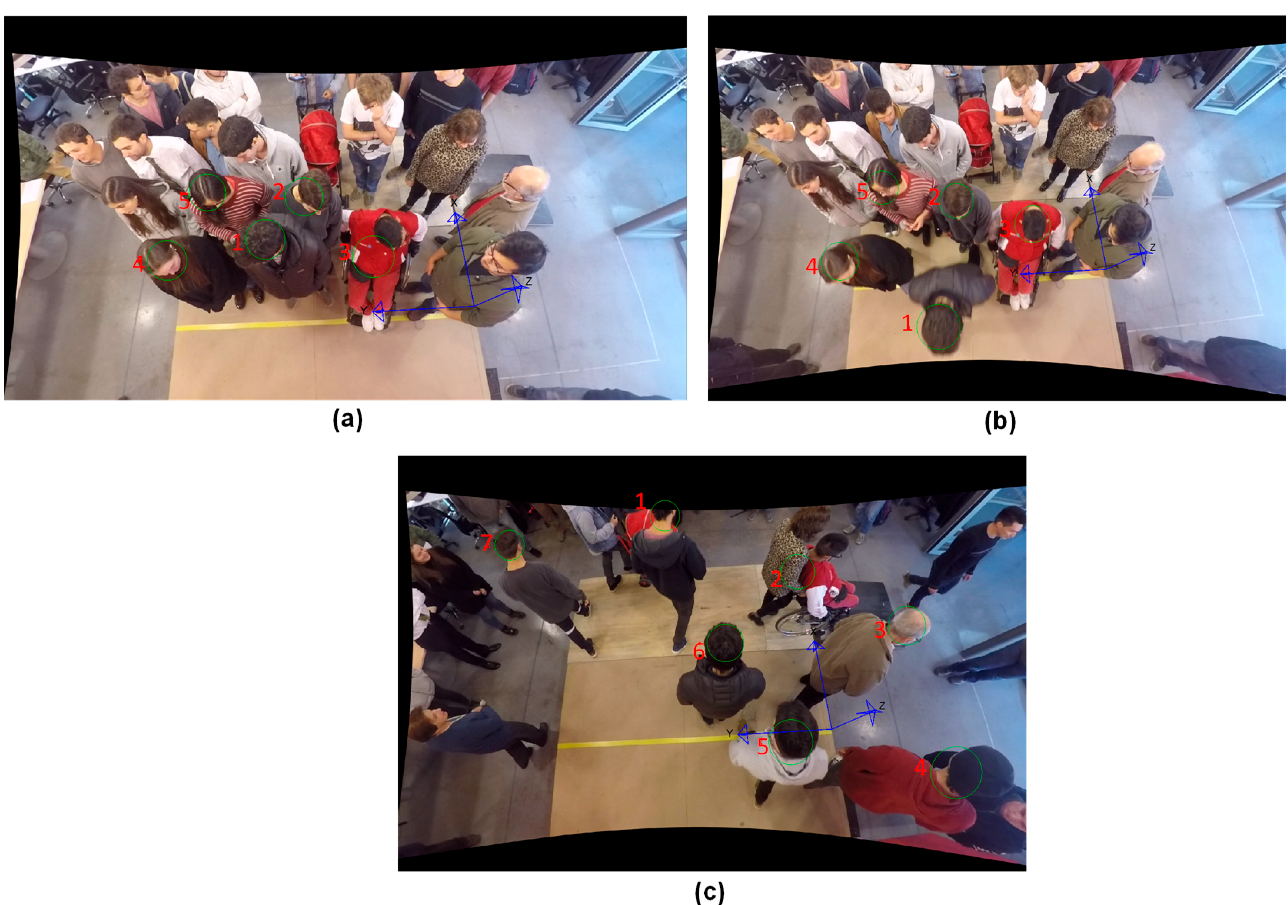
Figure 1. Platform used in the experiments at the laboratory in which passengers are detected (shown in green circle) and labeled (in red) from passenger N ◦ 1 to passenger N ◦ n , where n is the last passenger around passenger N ◦ 1: ( a ) passengers waiting to board the train; ( b ) passengers boarding the train; ( c ) passengers alighting the train.